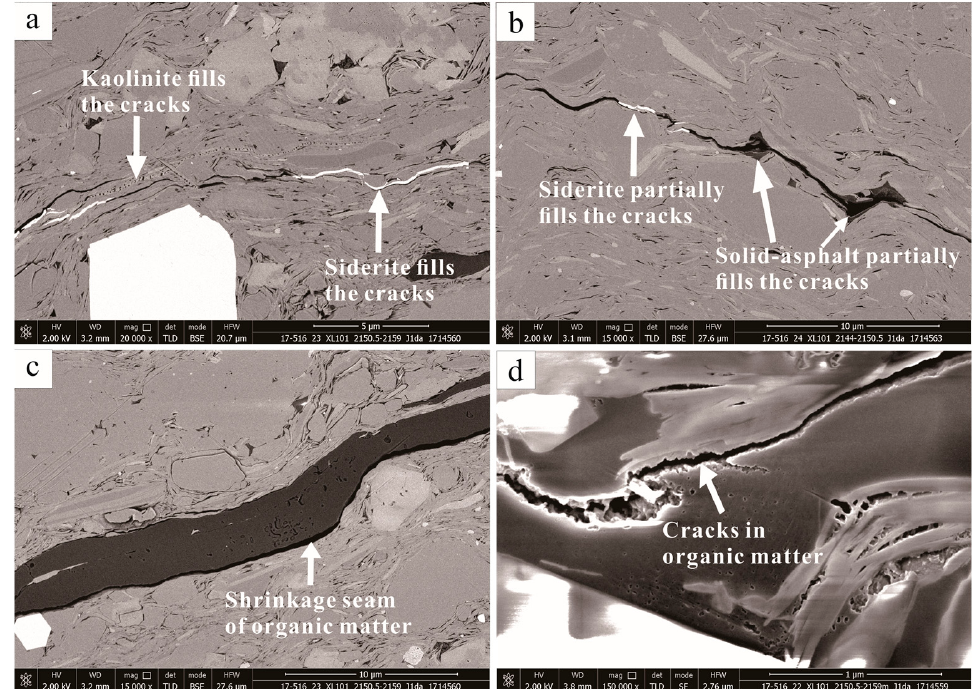
Figure 6. Scanning electron microscope microscopic characteristics of organic micro-fracture devel- opment in Da’anzhai shale. ( a ) Microcracks filled with kaolinite and siderite, Well XL101, 2150.5 m, Da’anzhai section. ( b ) Microcracks partially fi lled with siderite and solid bitumen, Well XL101, 2144 m, Da’anzhai section. ( c ) Organic ma tt er shrinkage fractures, Well XL101, 2150.5 m, Da’anzhai sec- tion. ( d ) Organic ma tt er internal fractures, Well XL101, 2150.5 m, Da’anzhai section.